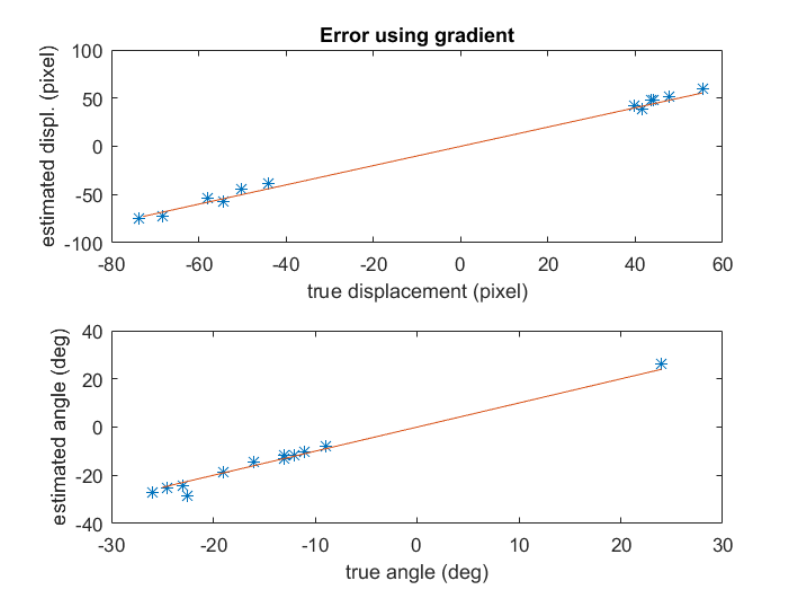
Figure 19. Proposed method error diagram.